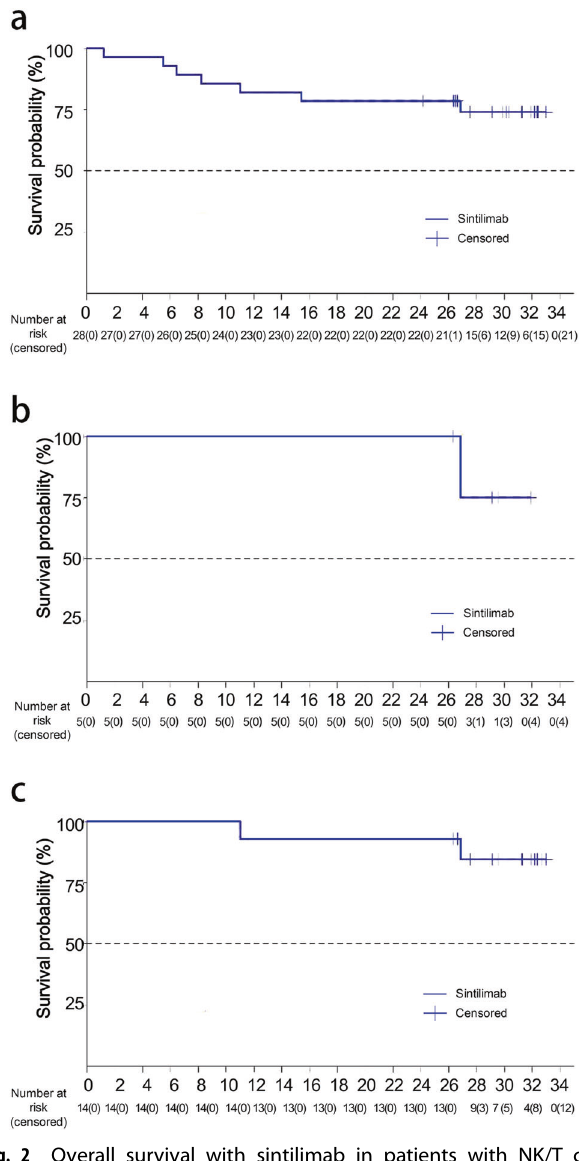
Fig. 2 Overall survival with sintilimab in patients with NK/T cell lymphoma. a Overall survival in all patients (28 patients) ( X -axis refers to time of follow-up in months). b Overall survival in patients with pseudo-progression (5 patients) ( X -axis refers to time of follow- up in months). c Overall survival in patients with the response pattern displayed as transient fl ares in different nodal groups without overall progression in the original target lesions (14 patients) ( X -axis refers to time of follow-up in